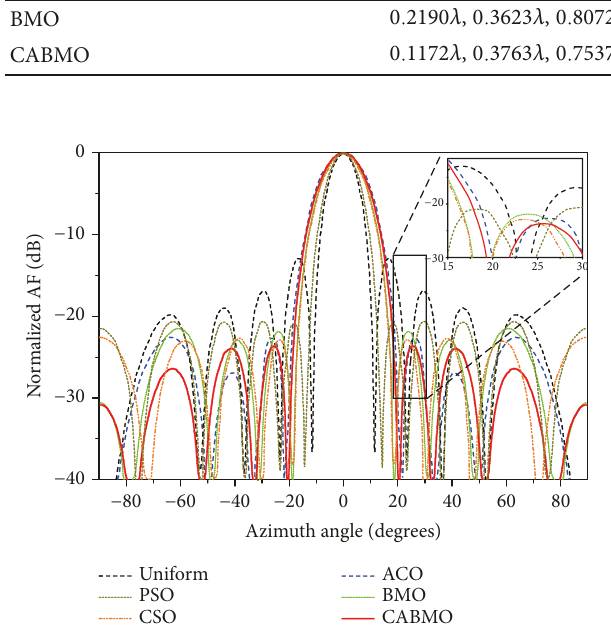
Figure 5: Nominalized AF of the 10-element LAA for case one. Table 3: The maximum SLL for the 10-element LAA for case one. Algorithm